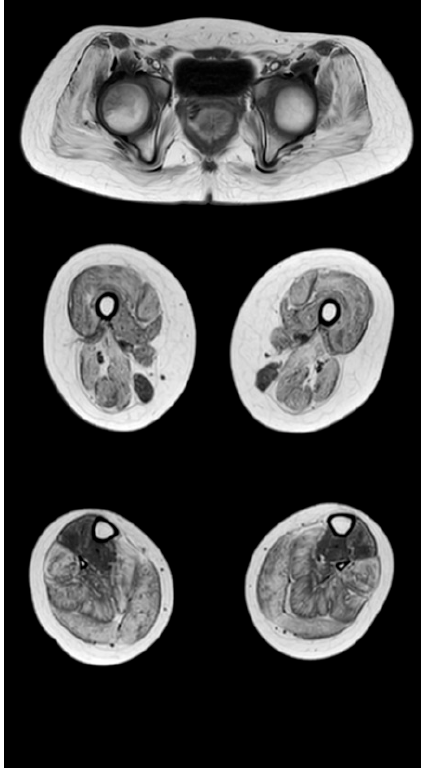
Figure 5. Pattern of involvement of the muscles of the lower extremities in a patient at a late non- ambulatory stage of the disease (13 years). From top to bottom: the pelvic level, the femoral level, and the level of the legs.